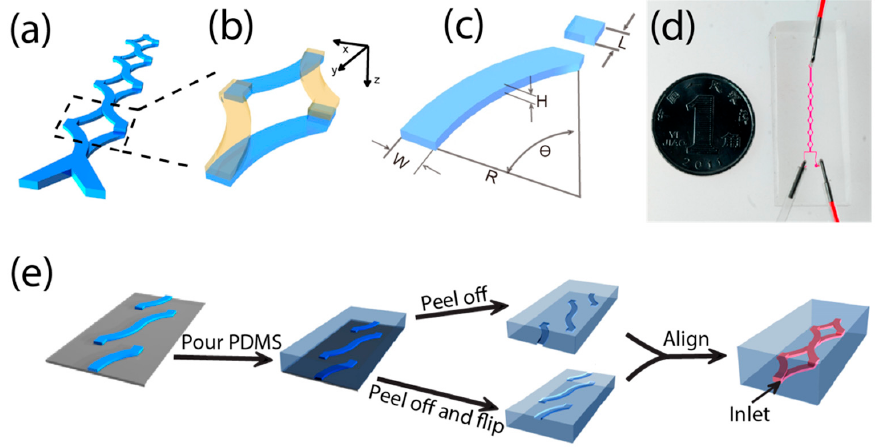
Figure 1. Schematic and fabrication of the mixer. ( a ) The 3D structure diagram of a mixer with two inlets and four SAR mixing cycles. ( b ) One cycle of the mixer that is constructed with two layers of microchannels. ( c ) Key structure parameters for the single unit of a mixer. ( d ) Image of a mixer with the channel filled with colorant. ( e ) Fabrication process of the mixer device.